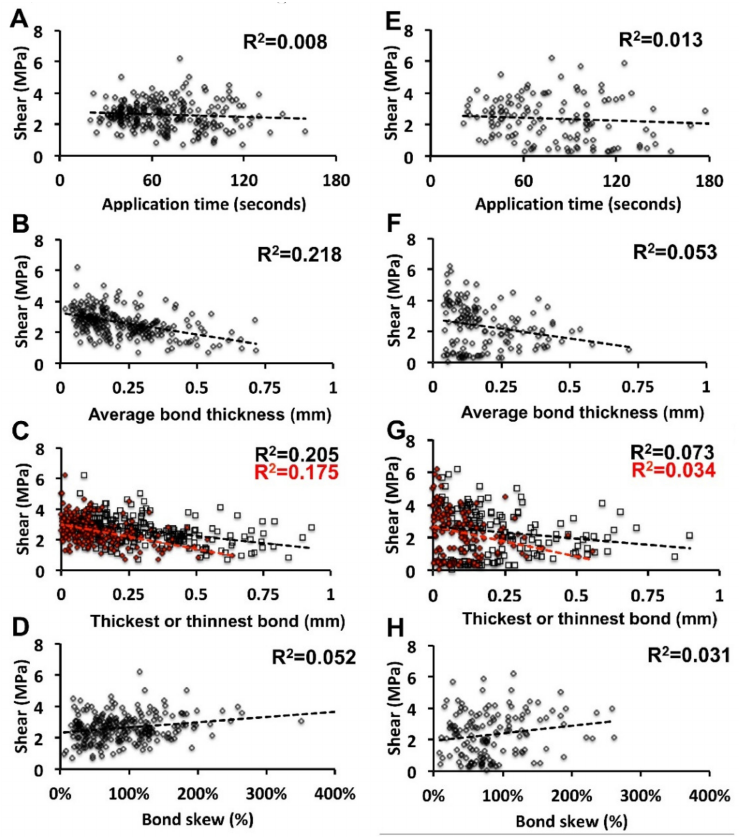
Figure 6. Scatter plot of PMC adhesive strength. ( A – D ) A scatter plot correlation of 27% PMC, cured in di ff erent conditions, between shear strength and application time, bond thickness, the thickest (black) / thinnest (red) bond, and bond unevenness. ( E – H ) A scatter plot correlation of di ff erent PMC formulations (27%–90%) between shear strength and application time, bond thickness, the thickest / thinnest bond, and bond